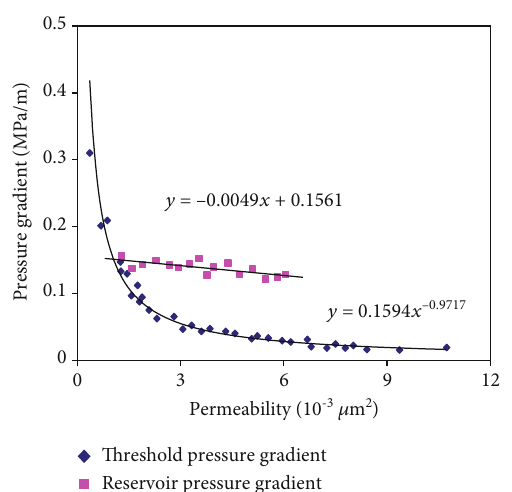
Figure 8: Relationship between permeability and threshold pressure